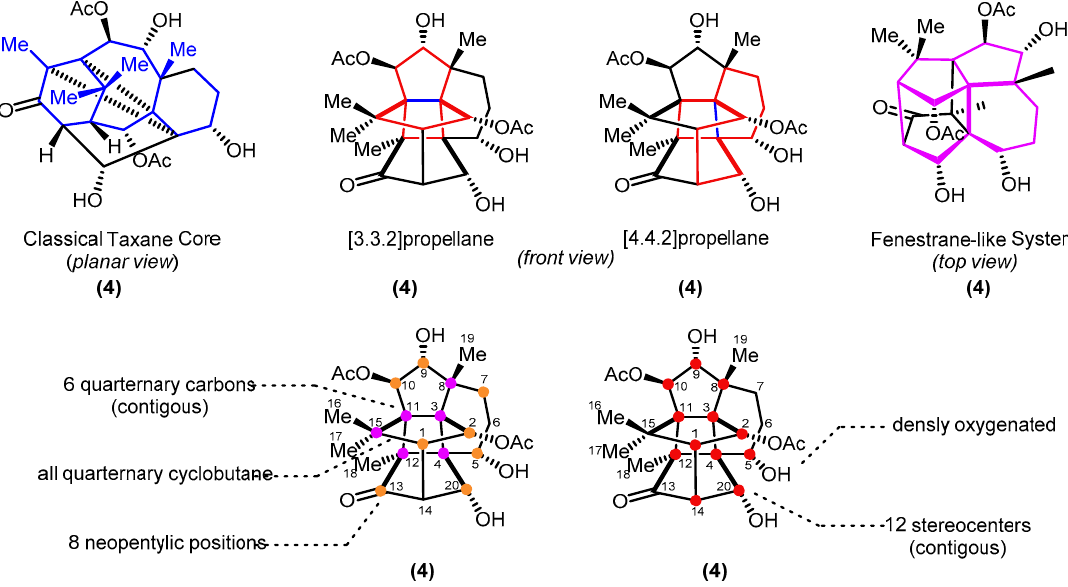
Figure 2. Comparison of the carbon backbone of taxol ( 2 ) and canataxpropellane ( 4 ). Figure 2. Di ff erent representations of canataxpropellane ( 4